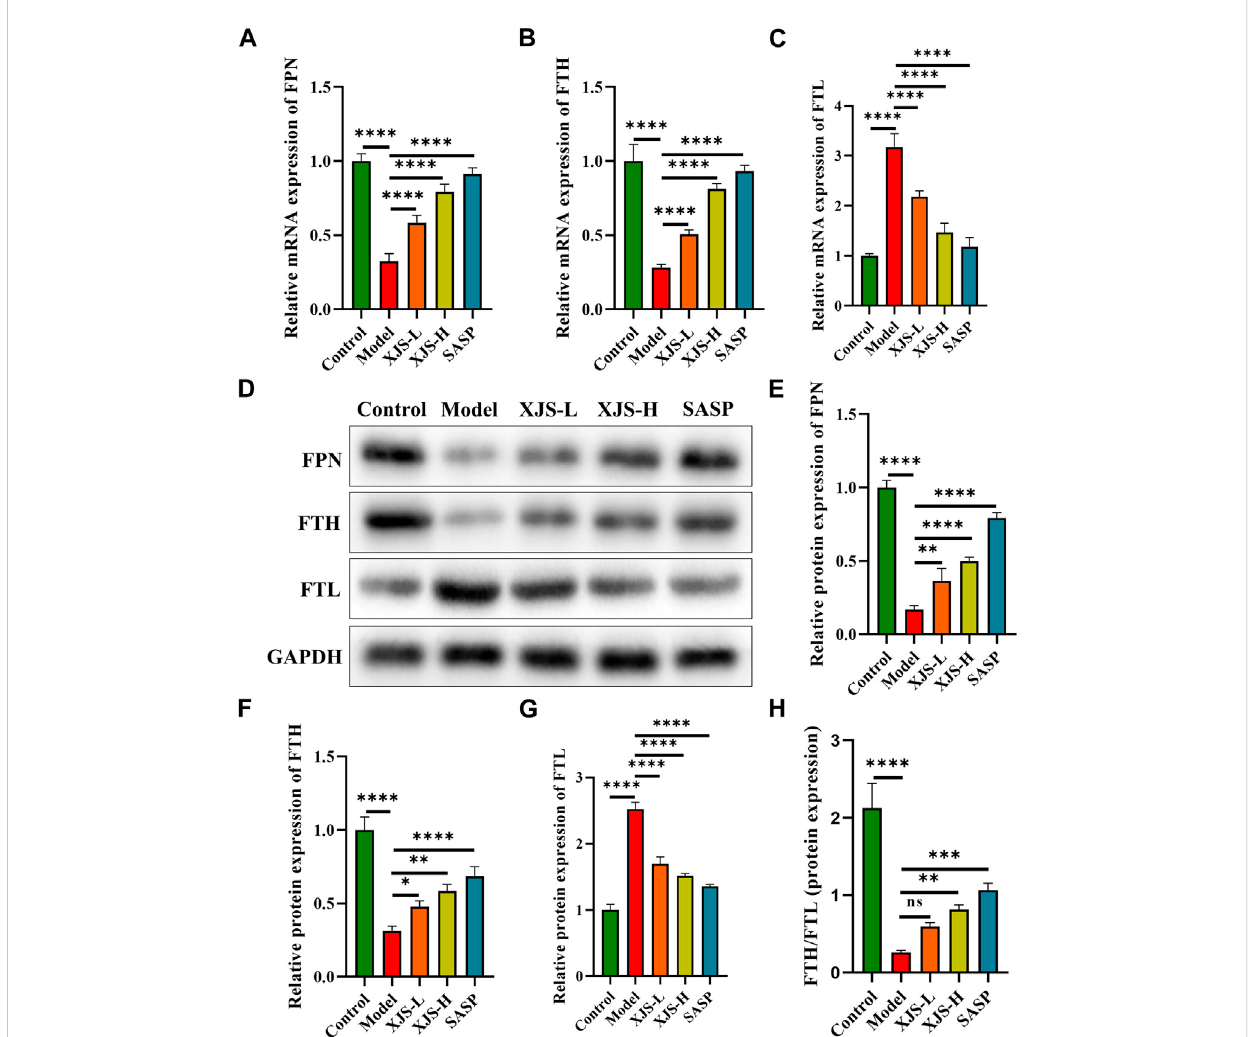
FIGURE 5 XJS regulated the transport and storage of iron in colon tissues of CD rats. (A – C) The mRNA expressions of FPN, FTH and FTL ( n = 6). (D – G) The protein expressions of FPN, FTH and FTL ( n = 3). (H) The ratio of FTH/FTL protein expression ( n = 3). * p < 0.05, ** p < 0.01, *** p < 0.001, **** p < 0.0001, ns = no signi fi